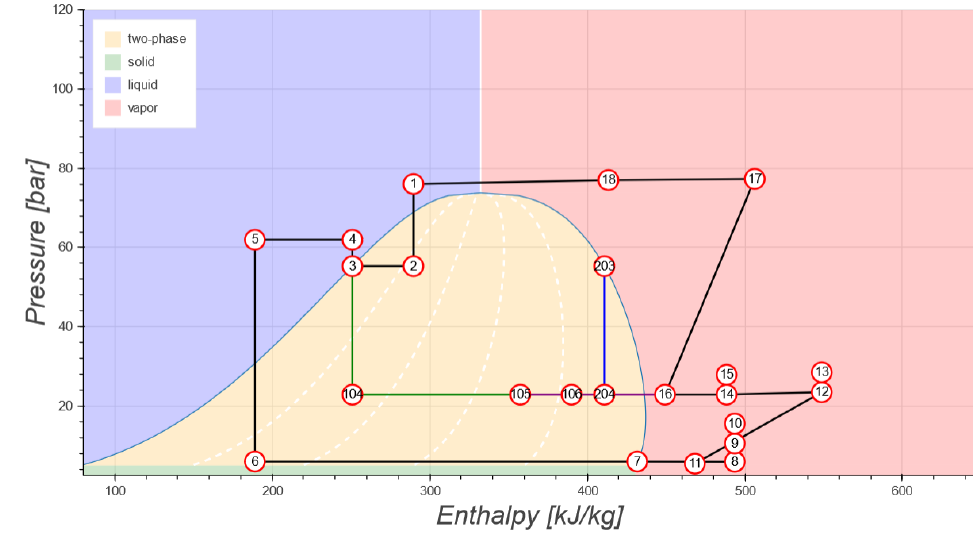
Figure 3. CO 2 pressure-enthalpy diagram with the process flow for the transcritical two-stage compressor cycle proposed for the